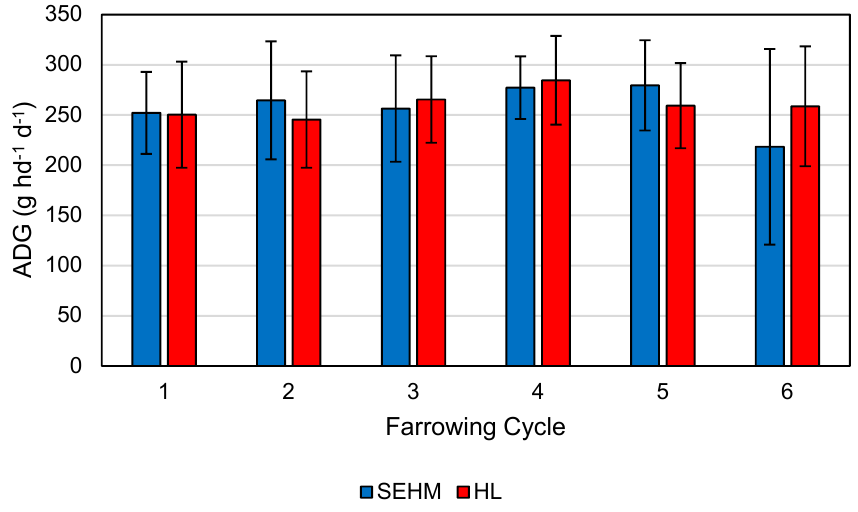
Figure 10. Average daily gain (ADG) across SEHM and HL treatments by farrowing cycle. Error bars represent one standard deviation of the farrowing cycle mean. This data represents the raw results, and thus, no statistical analysis between cycles was performed.